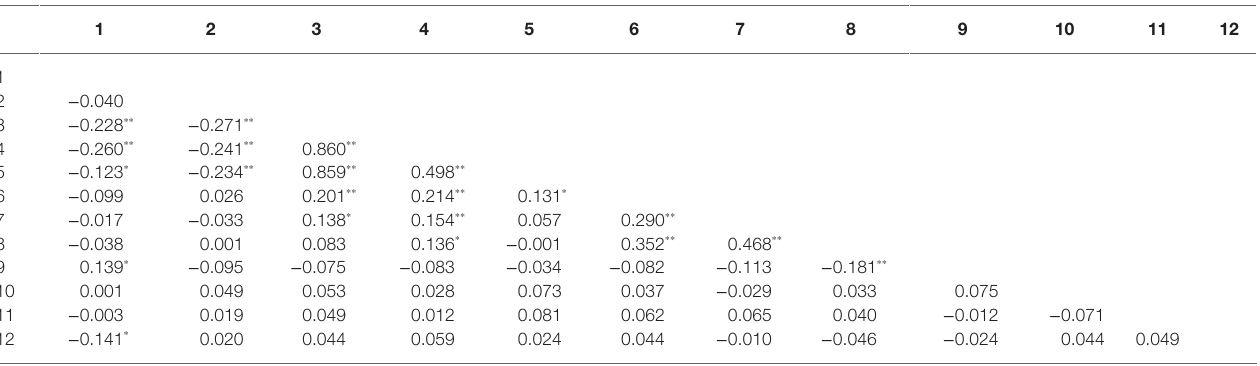
TABLE 2 | Intercorrelations among predictor and dependent variables ( N =